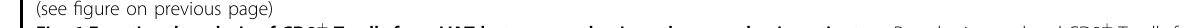
Fig. 6 Functional analysis of CD8 + T cells from VAT between cachexia and non-cachexia patients. a Pseudo-time ordered CD8 + T cells from VAT overlying the inferred cell trajectories by using Monocle. Pseudo-time was depicted from dark to light blue (upper). Pseudo-time ordered cells overlying the cell trajectories were labeled by indicated CD8 + T-cell clusters (lower). b Pseudo-time ordered cells classi fi ed by the cell origin. c Volcano plot showing the DEGs of CD8 + T cells in VAT from patients with or without cachexia. Red dots represented the selected genes of interest with signi fi cant upregulation during CAC, whereas blue dots were downregulated genes. d Representative images of the immunohistochemistry analyses for GZMB in greater omentum (VAT) sections for another 8 patients with gastric cancer. Positive staining was pointed with arrowhead lines. Scale bars: 50 μ m. e Scatter plot showing the negative correlation between the mean diameters of adipocytes in each section and the number of GZMB-positive cells. Linear regression and Pearson ’ s correlation test with 95% CI were performed and the line of the best fi t was shown in the plot. f Bar plot showing the inferred percentage of cytotoxic CD8 + T cells in all immune cells for both cancer with weight stable (CWS) and cancer with weight loss (CWL) group. P -value was determined by Student ’ s t -test. * P < 0.05. g Heatmap plot depicting the row scaled expression values of indicated pro-catabolic cytokines within each cell type from VAT, separated by the disease condition. h Representative images of adipocytes co- cultured with murine primary splenic CD8 + T cells activated in vitro for 24 h. Scale bars: 25 μ m. i Density plot showing the distribution of diameters of droplets within adipocytes in each group. The diameters were measured from three randomly selected fi eld for each well, at 40× magni fi cation ( n = 3/group). j Supernatant glycerol levels of adipocytes under each co-culturing condition, normalized by the glycerol concentrations in medium under co-culturing with pre-stimulated CD8 + T cells. Bars indicate means ± SEM. P -values were determined by one-way ANOVA and post hoc Dunnett ’ s multiple-comparison correction tests. k Western blot analysis of the phosphorylation of HSL and the expression of ATGL in each co- culturing condition ( n = 3/group). l Quanti fi cation of results from the penal k. Bars indicate means ± SEM. P -values were determined by one-way ANOVA with post hoc Dunnett ’ s multiple-comparison correction